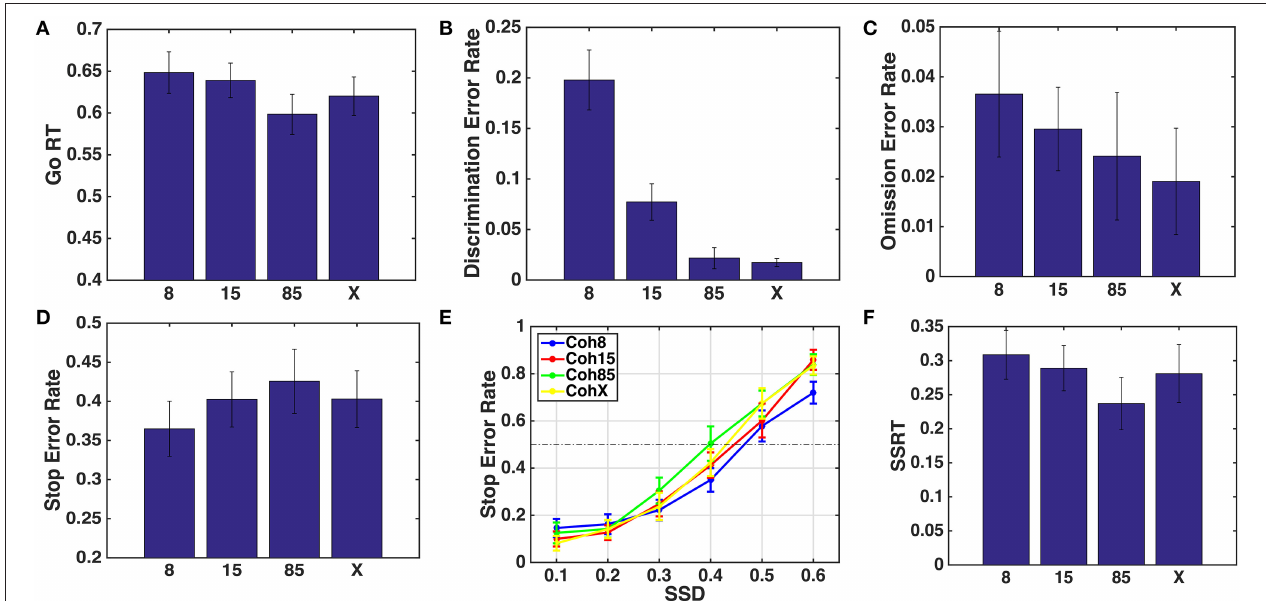
FIGURE 5 | Behavioral data for varying go stimulus discrimination difficulty. 8, 15, 85 denote different coherences of random dot motion stimulus. X denotes square vs. circle discrimination task. (A) Mean Go RT decreased as the discrimination task became easier. Bar height indicates the mean of median Go RT (for each subject) for each condition. (B) Go discrimination error rate decreased as coherence increased. (C) Go omission error rate decreased with coherence. (D) Stop error rate increased with coherence. (E) Average inhibition function for different stimulus types. (F) SSRT decreased with coherence.